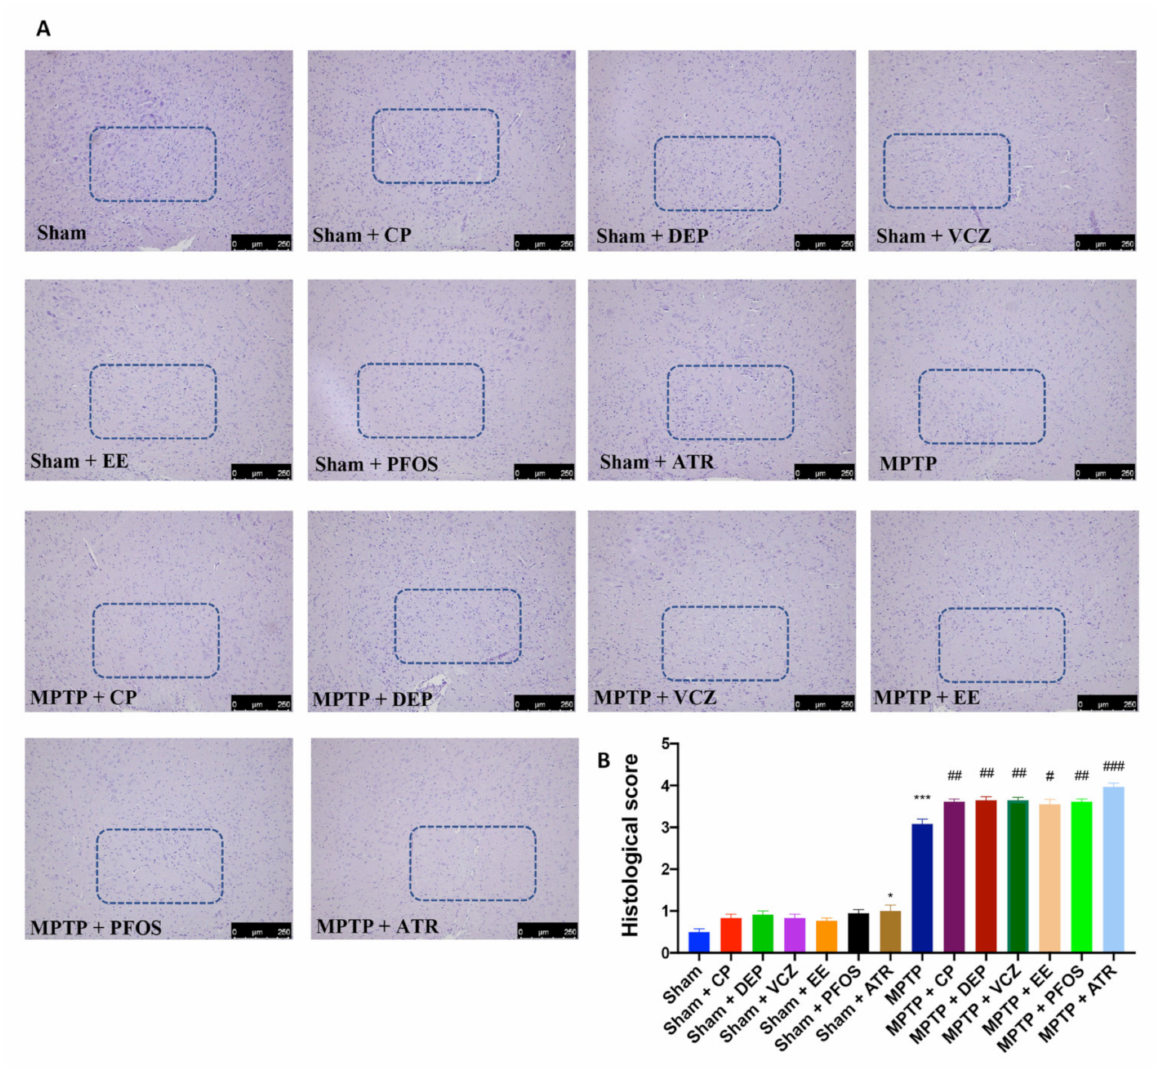
Figure 1. Histological evaluation of the midbrain from all groups ( A ). Histological score ( B ). A 10 × magnification is shown (250- µ m scale bar). The blue box highlights the area affected by the damage. Data are expressed as the mean ± SEM of N = 6 mice/group. * p < 0.05 vs. sham; *** p < 0.001 vs. sham; # p < 0.05 vs. MPTP; ## p < 0.01 vs. MPTP; ### p < 0.001 vs.